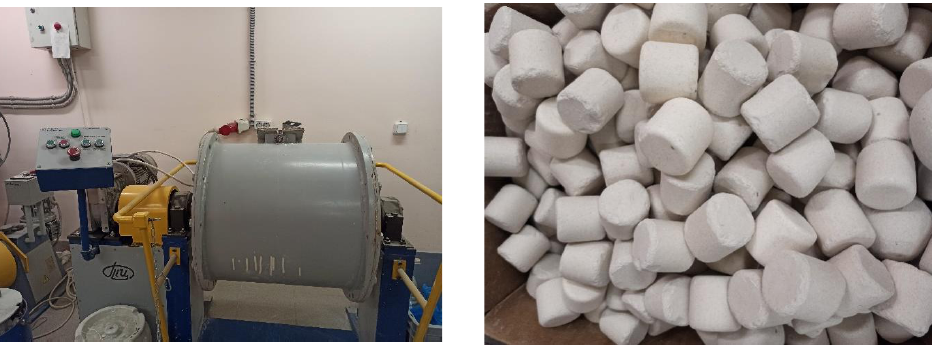
Figure 5. Ball mill and grinding bodies used to grind GBFS.